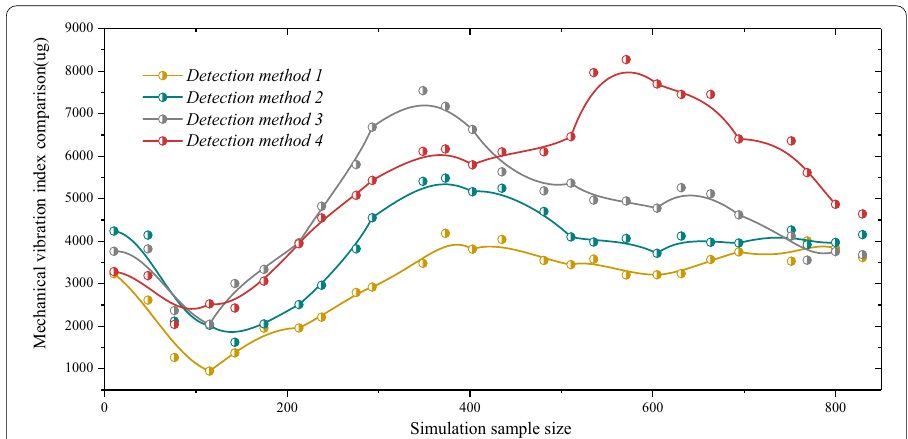
Fig. 7 Comparison of the quality of the original signal and the reconstructed signal with a compression rate of 30%